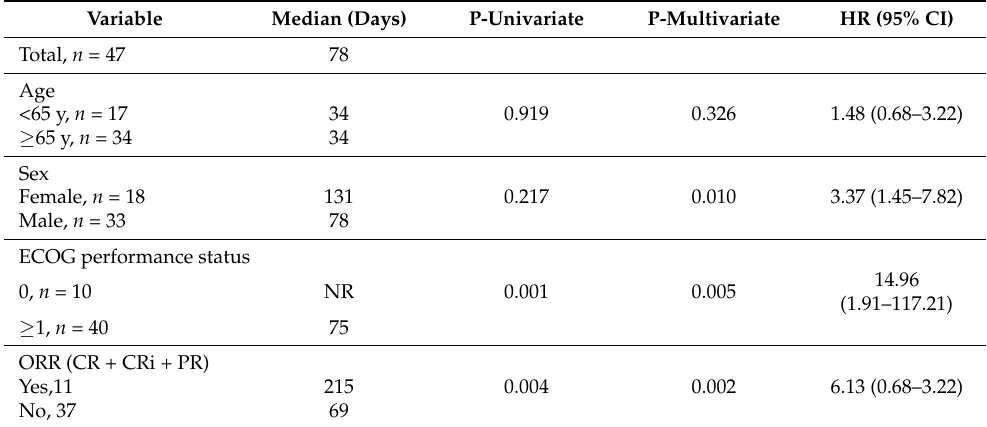
Table 2. Multivariate analysis of factors influencing survival in R/R-AML patients treated with